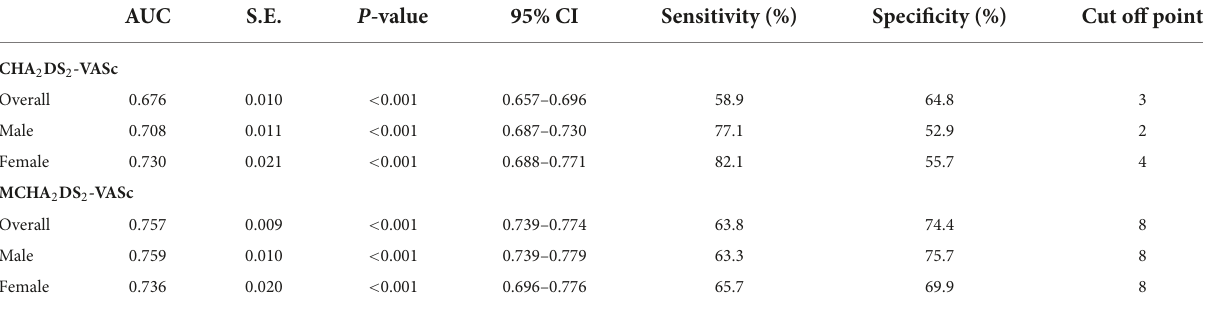
TABLE 4 Predictive ability, sensitivity, and specificity of CHA 2 DS 2 -VASc and MCHA 2 DS 2 -VASc scores for recurrent myocardial infarction development, presented overall, and stratified by sex.